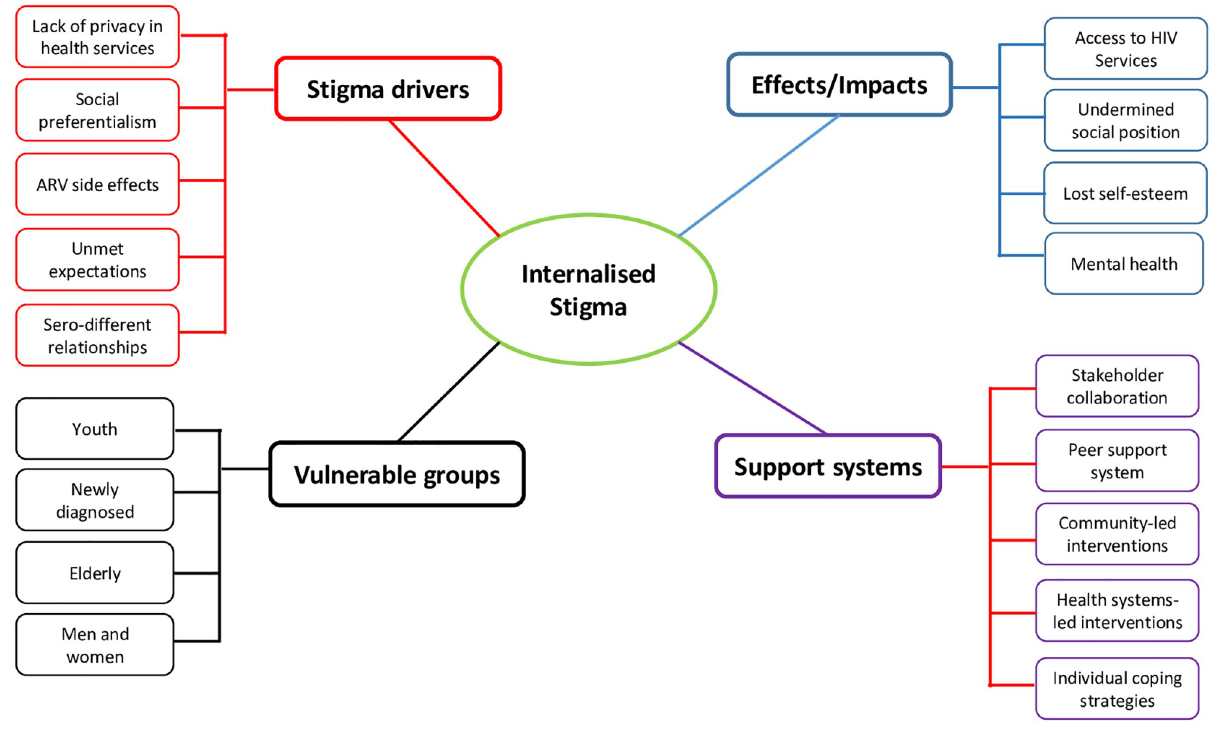
Fig 2. Emerging themes and